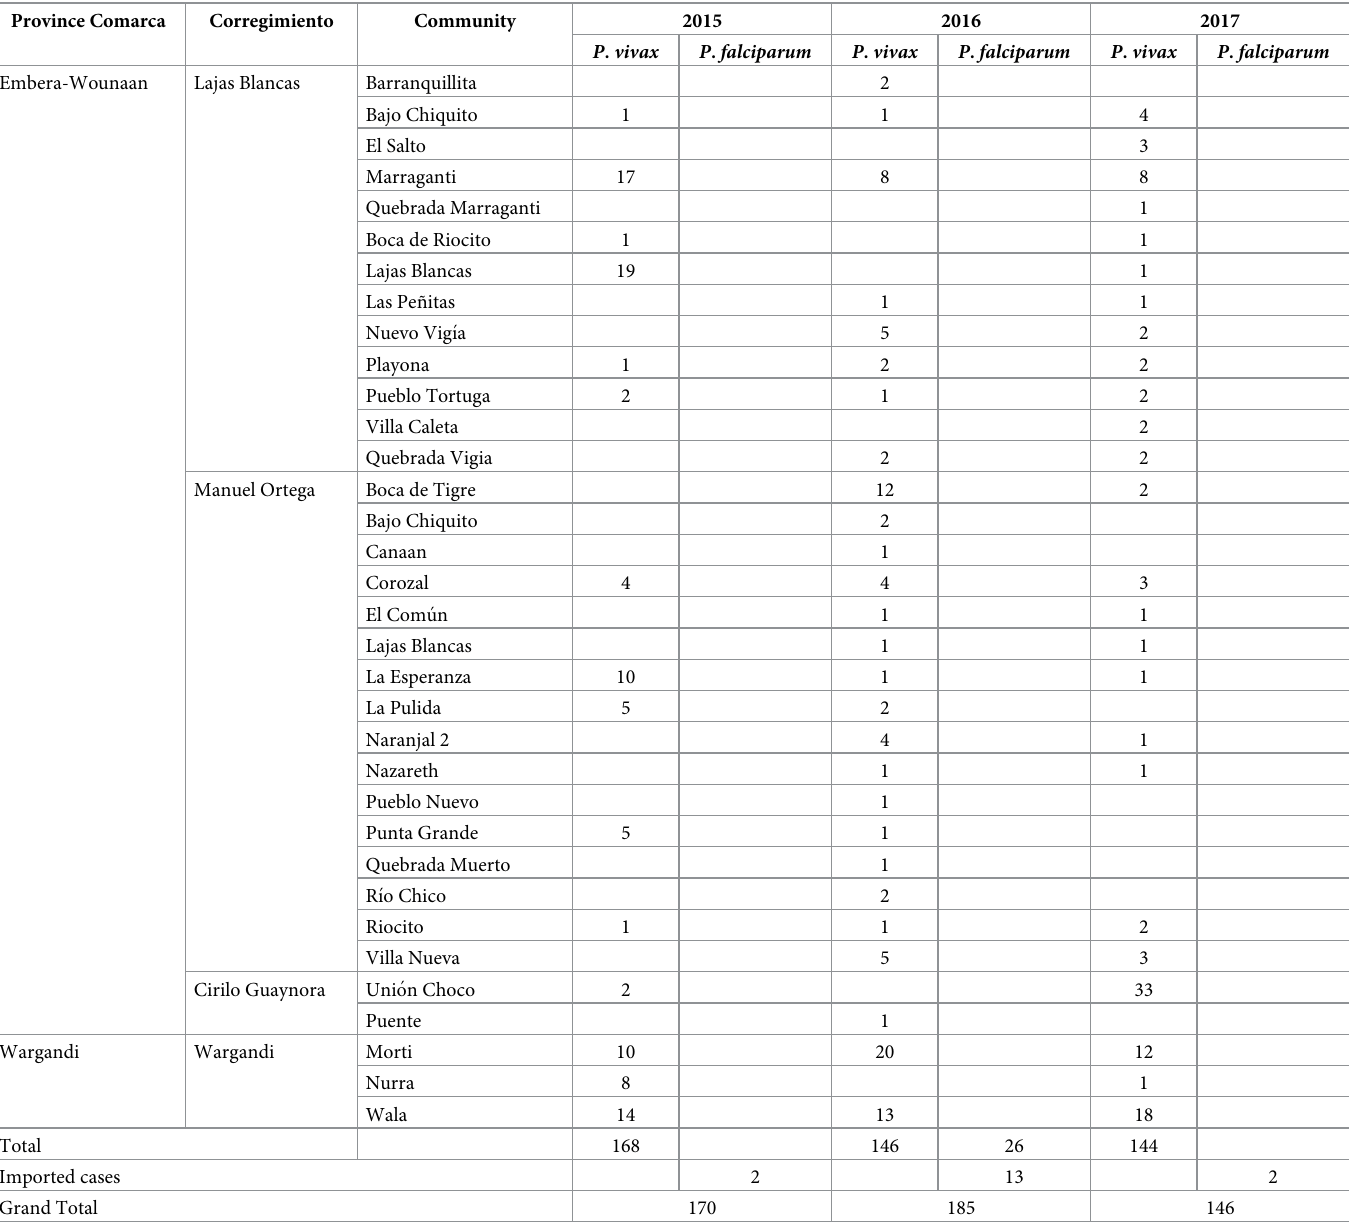
Table 2. Distribution of cases malaria by corregimientos and community in Regio´n Darien. 2015 to 2017. Province